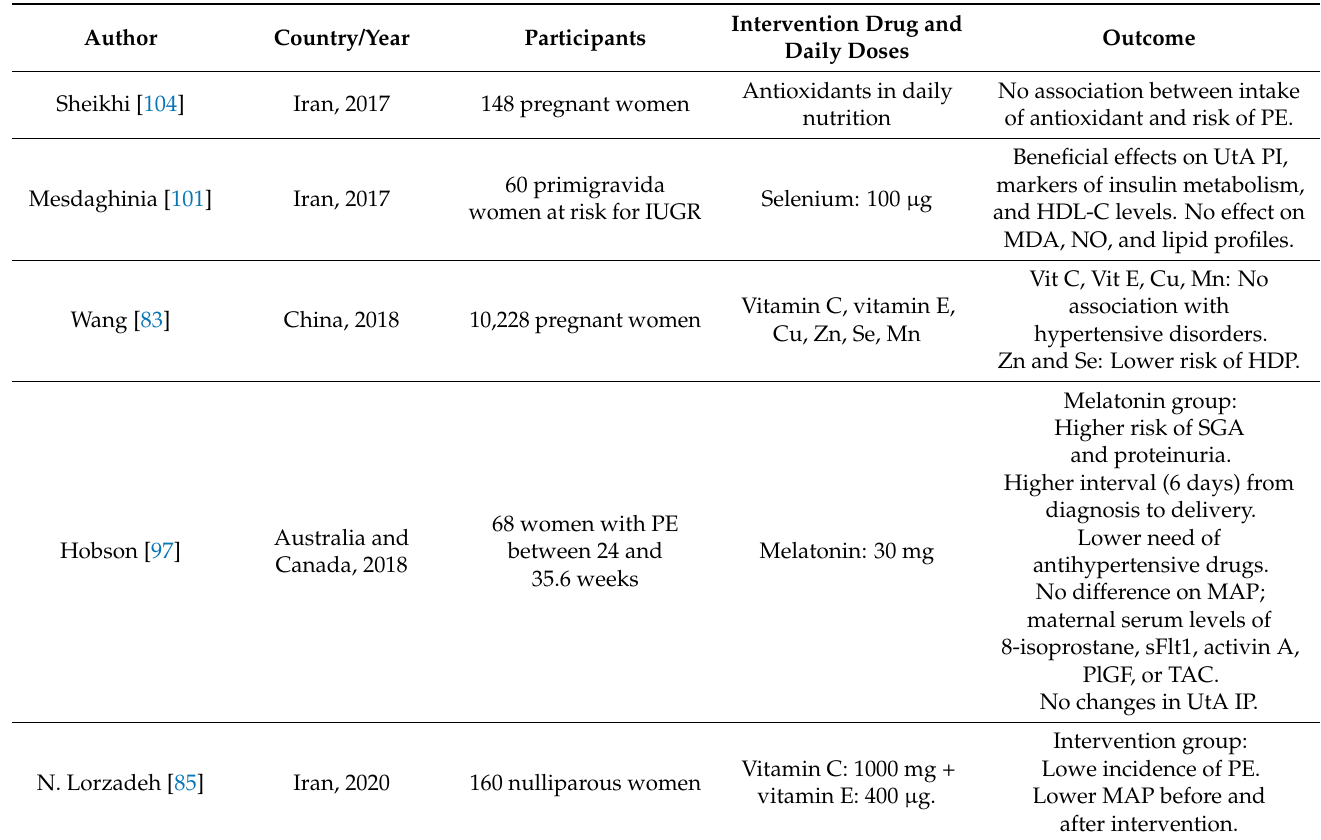
Table 2. Main trials relating antioxidants with gestational hypertensive disorders performed